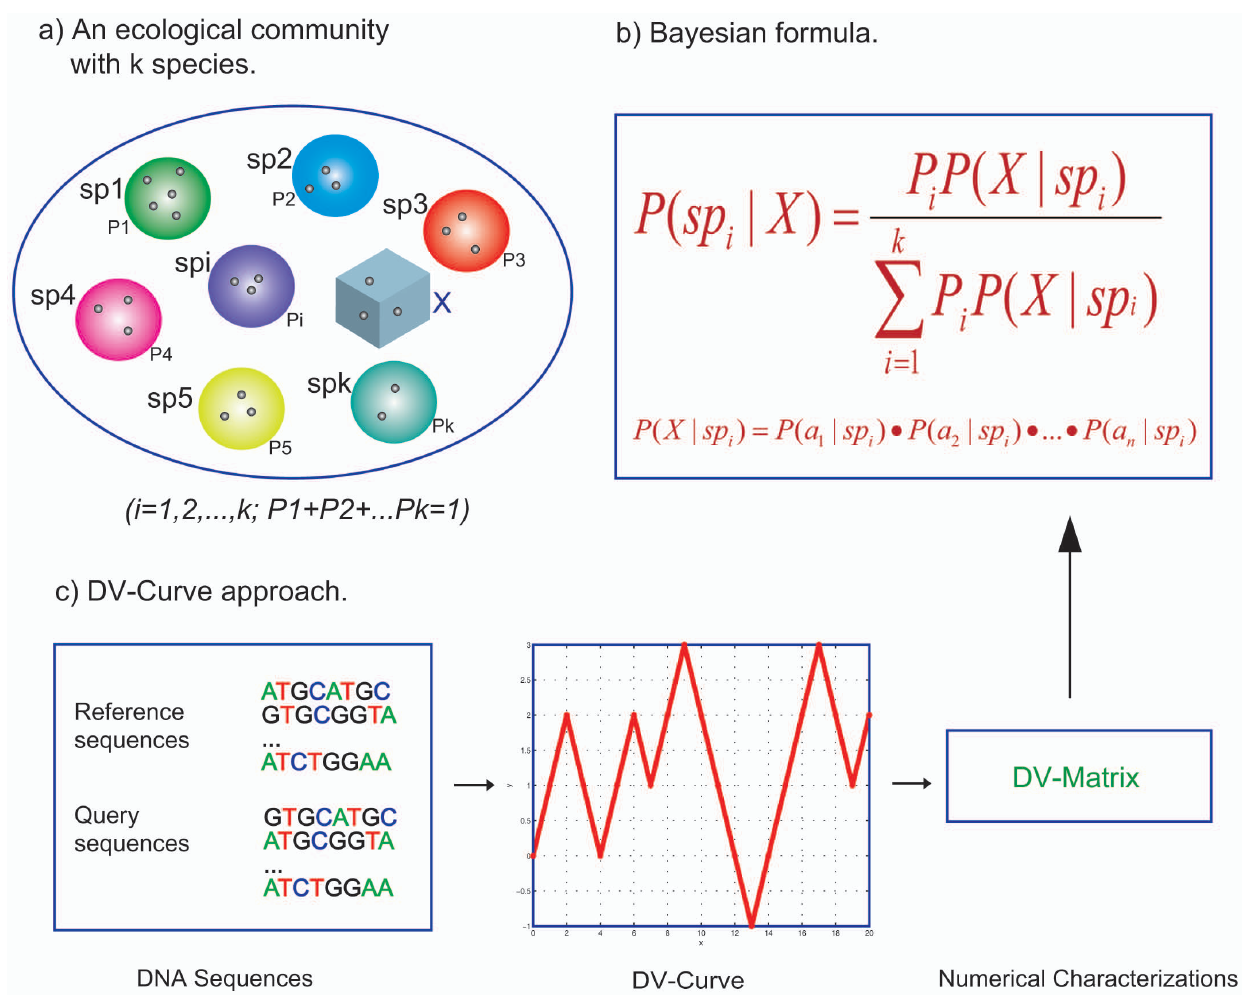
Figure 6. Species identity inferred via DNA barcoding for a community with a Bayesian method. (a) An ecological community with species. (b) Bayesian formula used to infer species membership for unknown samples. (c) DV-Curve approach to construct DV-Matrix for Bayesian inference. sp i is the i th species in the community, X is an unknown sample with DNA sequenced, P i is the probability of a sample belonging to sp i . P ( sp i D X ) is the conditional probability of the unknown sample X belonging to sp i given that its DNA is sequenced. P ( X D sp i ) is the probability of having DNA sequence of the unknown sample X given that DNA sequences of sp i are known.